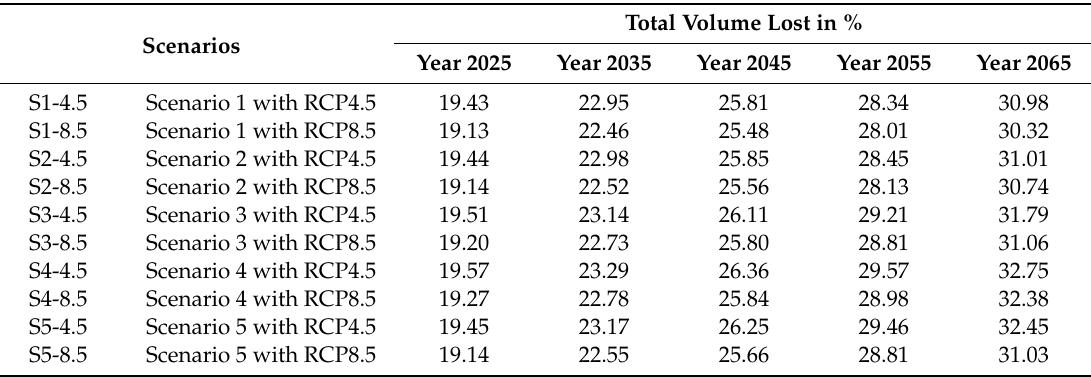
Table 6. Total volume loss of the reservoir in